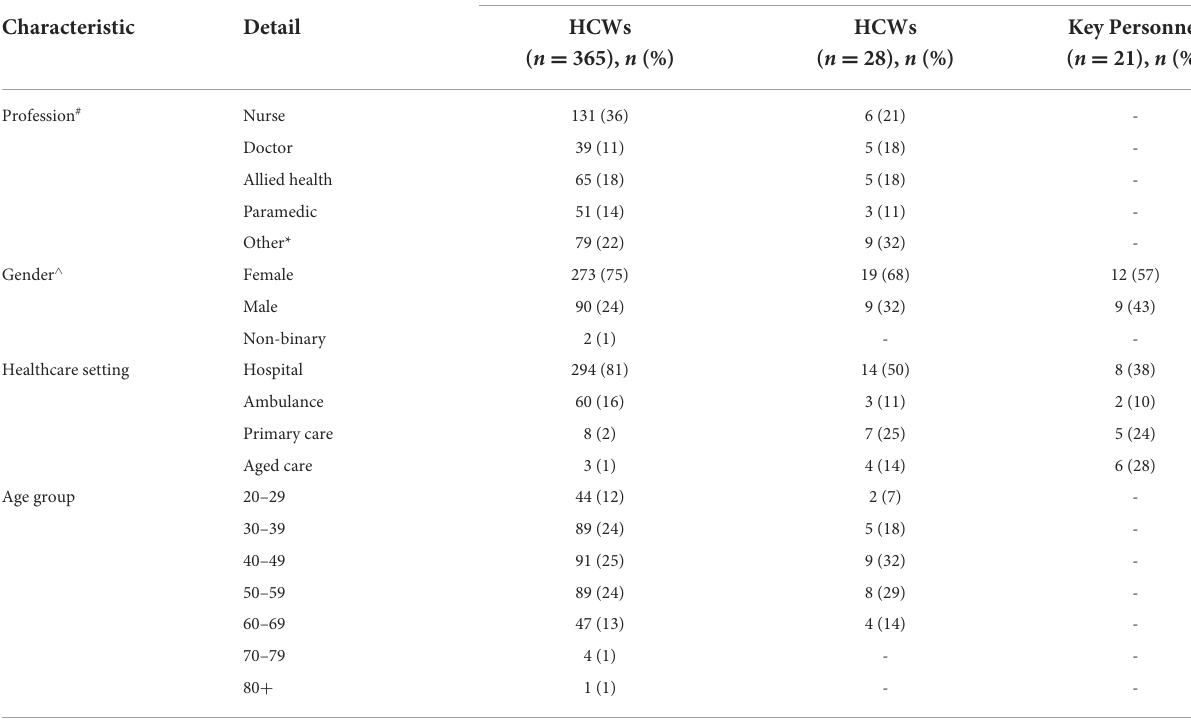
TABLE 1 Participant